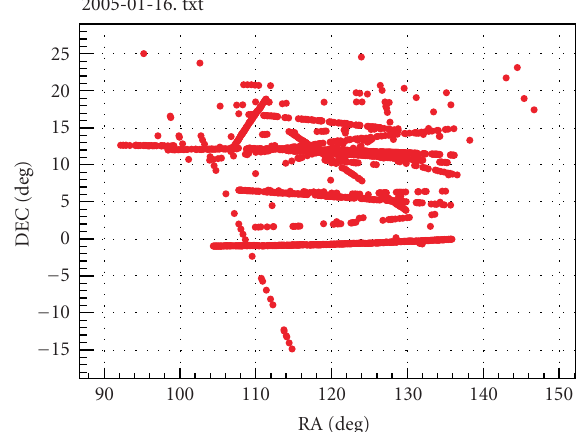
Figure 5: Events rejected by track cut during single night 2005-01-